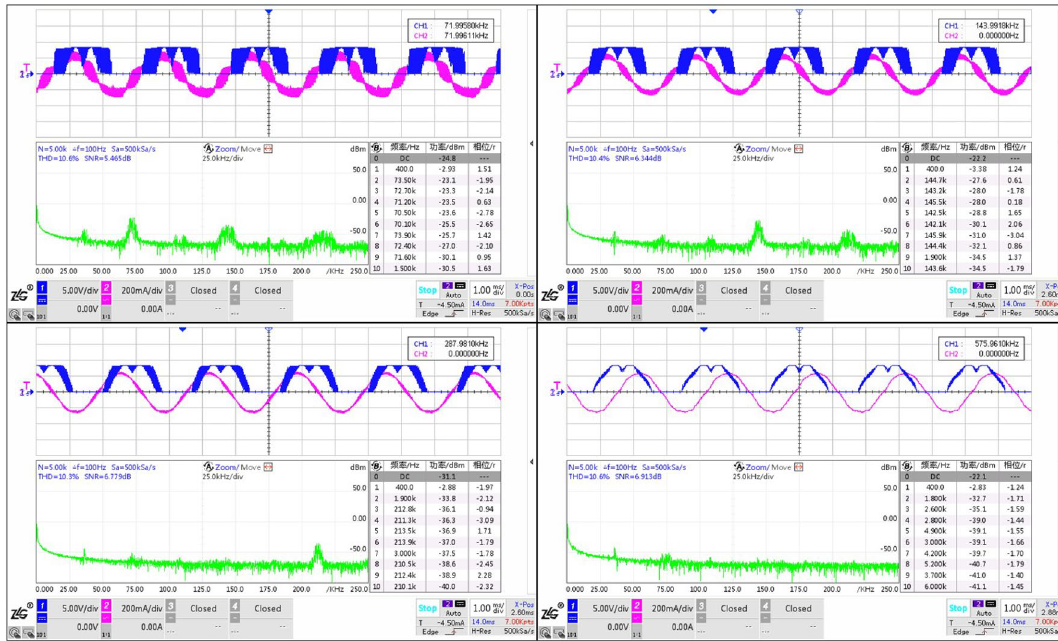
Figure 13. Experiment results of fundamental frequency: top-left for 72 kHz, top-right 144, bottom-left 288, bottom-right 576; red part for I s , blue V a , green frequency spectrum.